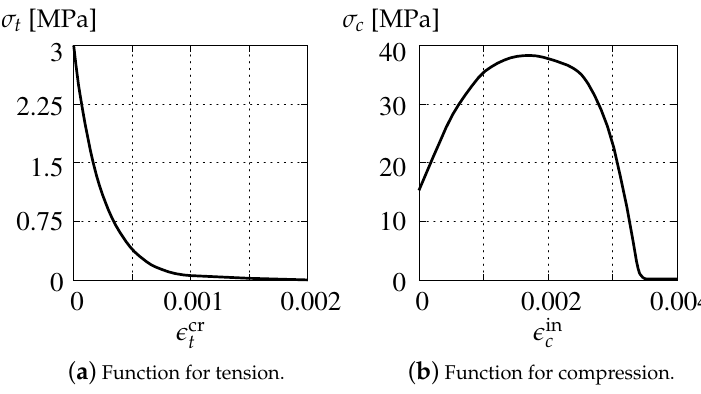
Figure 7. Material stress–strain relations for CDP